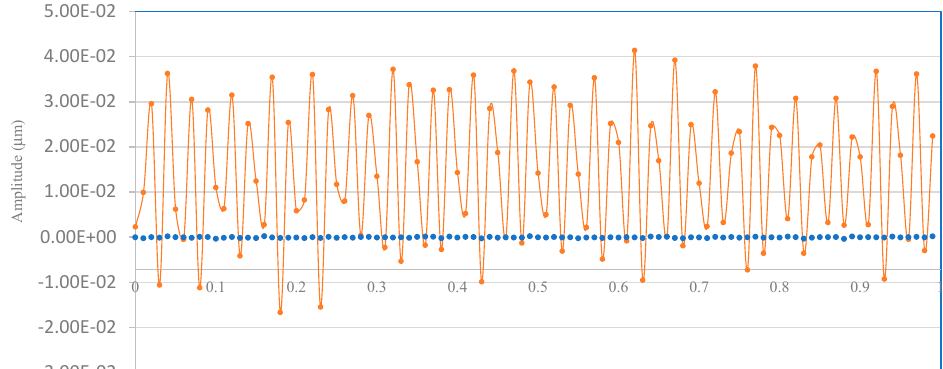
Figure 7 . Wire vibration displacement measurements .